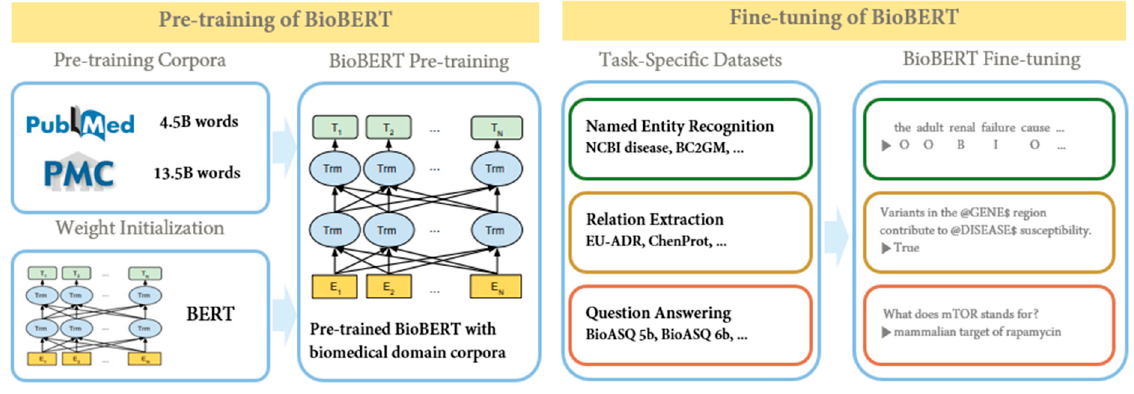
Figure 3. BioBERT’s pre-training and fine-tuning schematic diagram (cited from [9]).